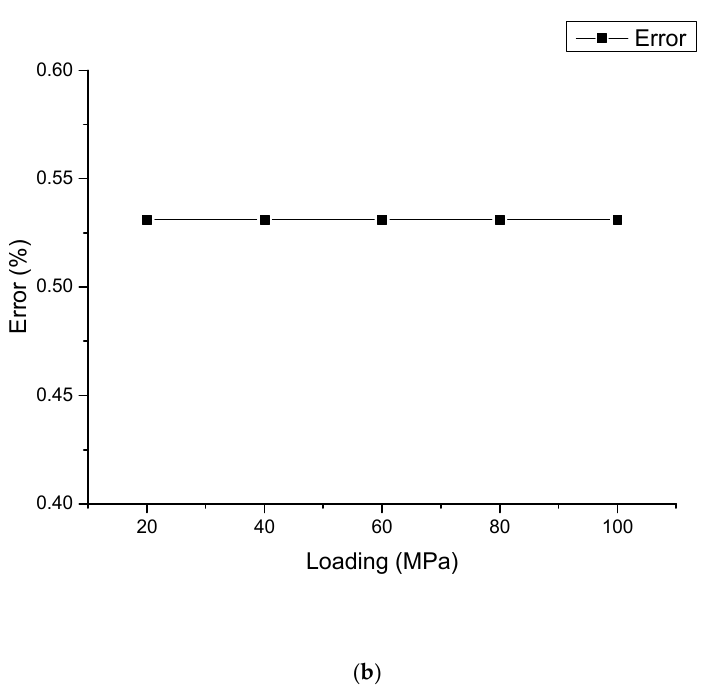
Figure 2. Verification of simulation accuracy. ( a ) Verification of simulation value output from ABAQUS; ( b ) Errors between the two values of each loading